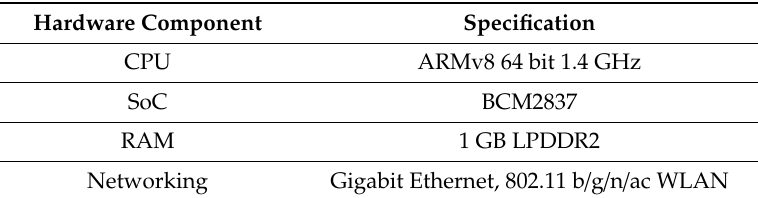
Table 3. Experiment